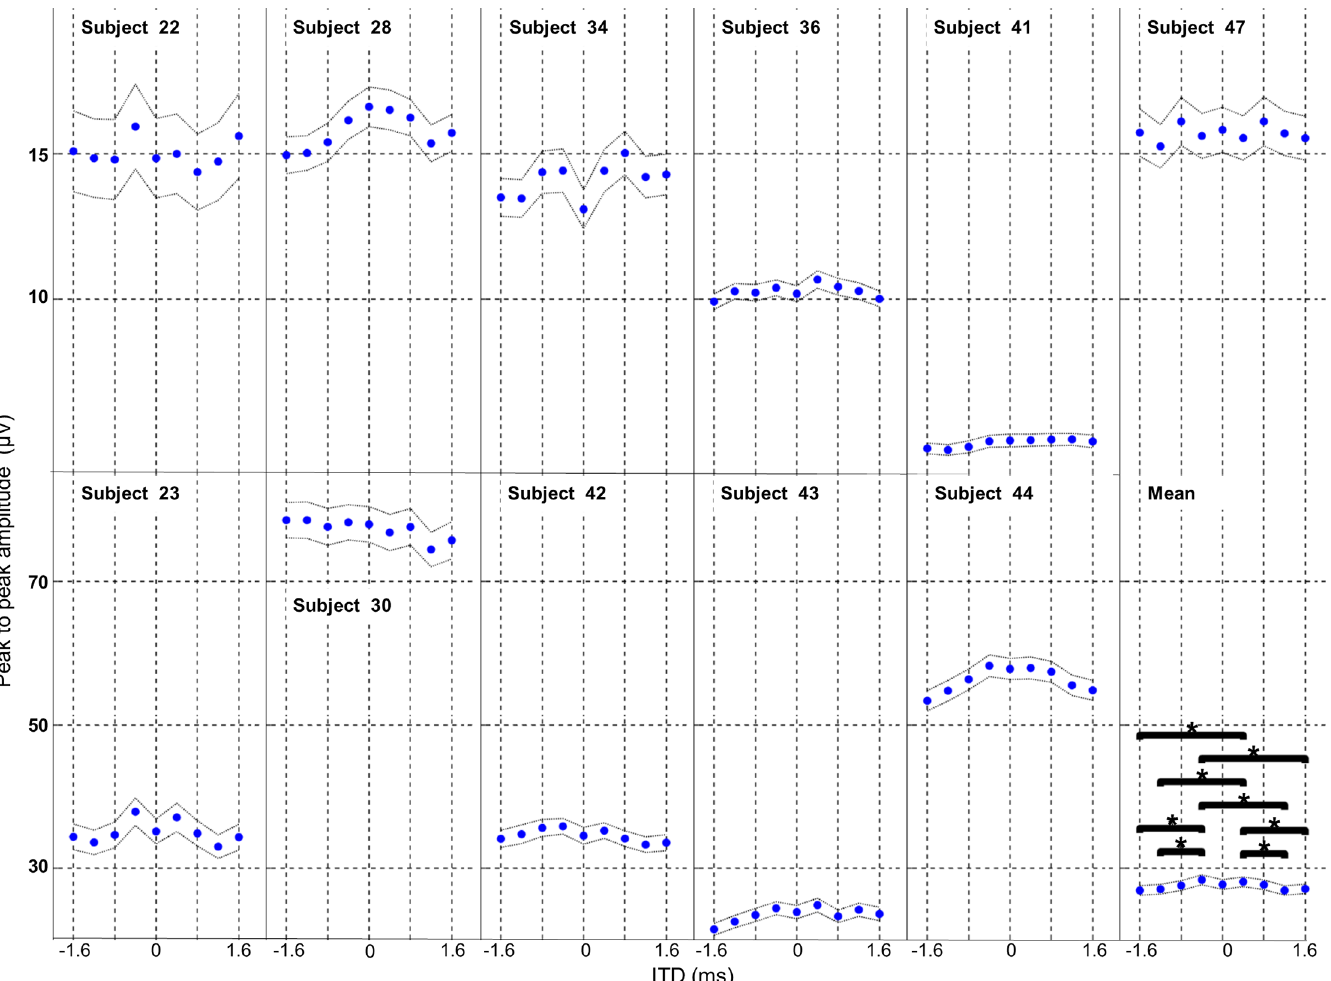
Fig 2. Effect of ITD on average peak to peak amplitude. The average peak to peak amplitude of the PAM response is shown for 9 ITD conditions for each of the 11 experimental subjects and the overall group mean. Negative ITD’s indicate an ipsilateral delay (sound in perceived as coming from the contralateral side to the recorded PAM). Positive ITDs indicate a contralateral delay (sound in perceived as coming from the ipsilateral side to the recorded PAM). Horizontal bars indicate pairwise Tukey’s comparisons and asterisks indicate significance at p < 0.05. Fine dotted lines show the 95% confidence